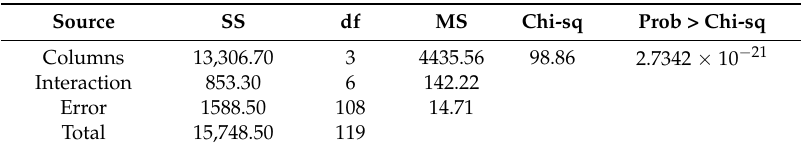
Table 13. Friedman test table for the F1